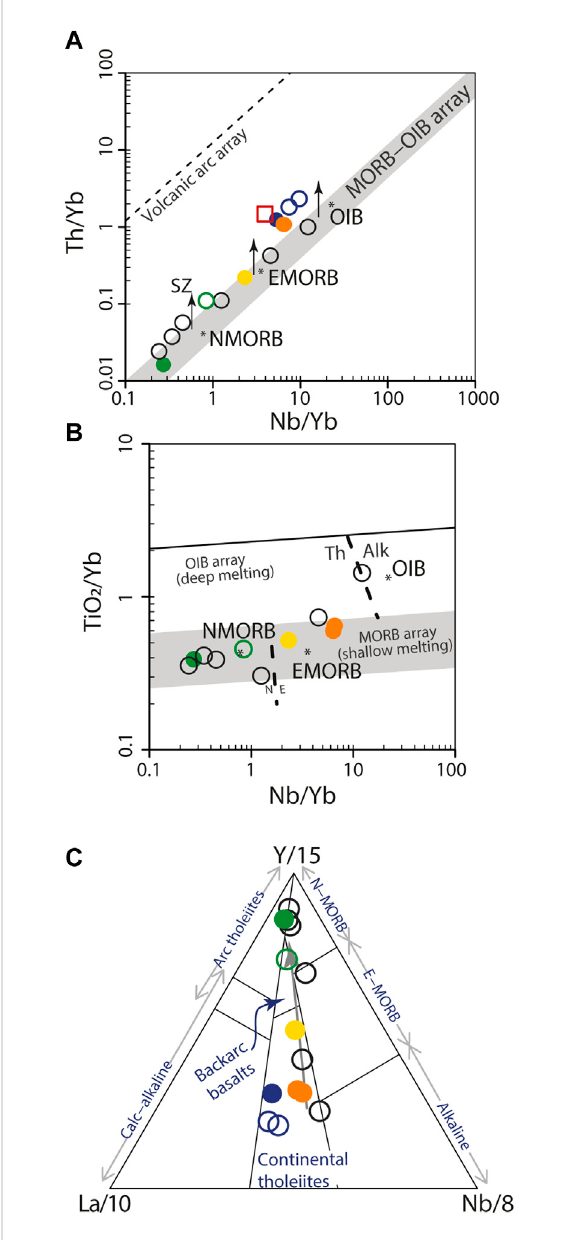
FIGURE 6 (A,B) Th/Nb vs. Nb/Yb and TiO 2 /Yb vs. Nb/Yb diagrams of Pearce (2008). The composition of the Zarao metarhyolites is plotted for its comparison. SZ: subduction zone in fl uence. The OIB, E-MORB, and N-MORB composition of Sun and McDonough (1989) is shown for comparison. (C) Y – La – Nb tectonicdiscriminationdiagramofCabanisandLecolle(1989).The composition of the Zarao metarhyolite is shown for comparison. The gray arrow shows the expected evolutionary trend for the magmatism from a continental setting to a backarc setting. Same symbols as in Figure